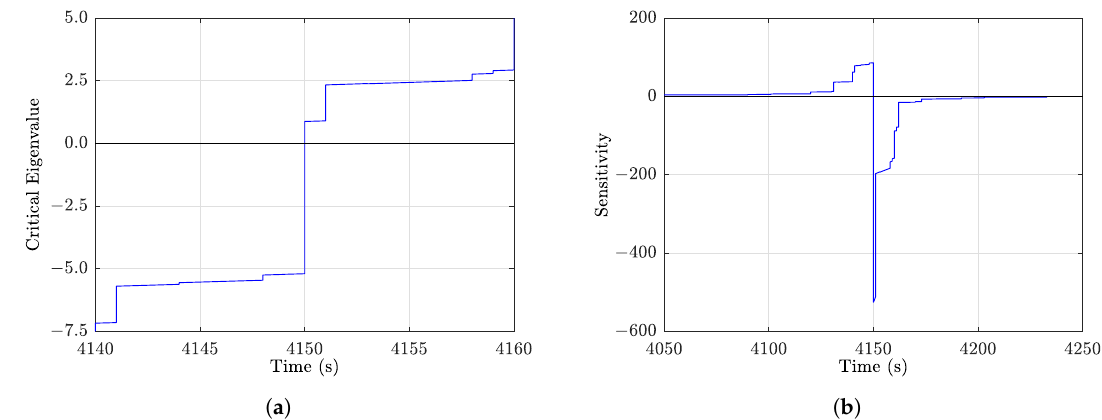
Figure 6. Unstable scenario response of ( a ) critical eigenvalue and ( b ) Sensitivity S Q